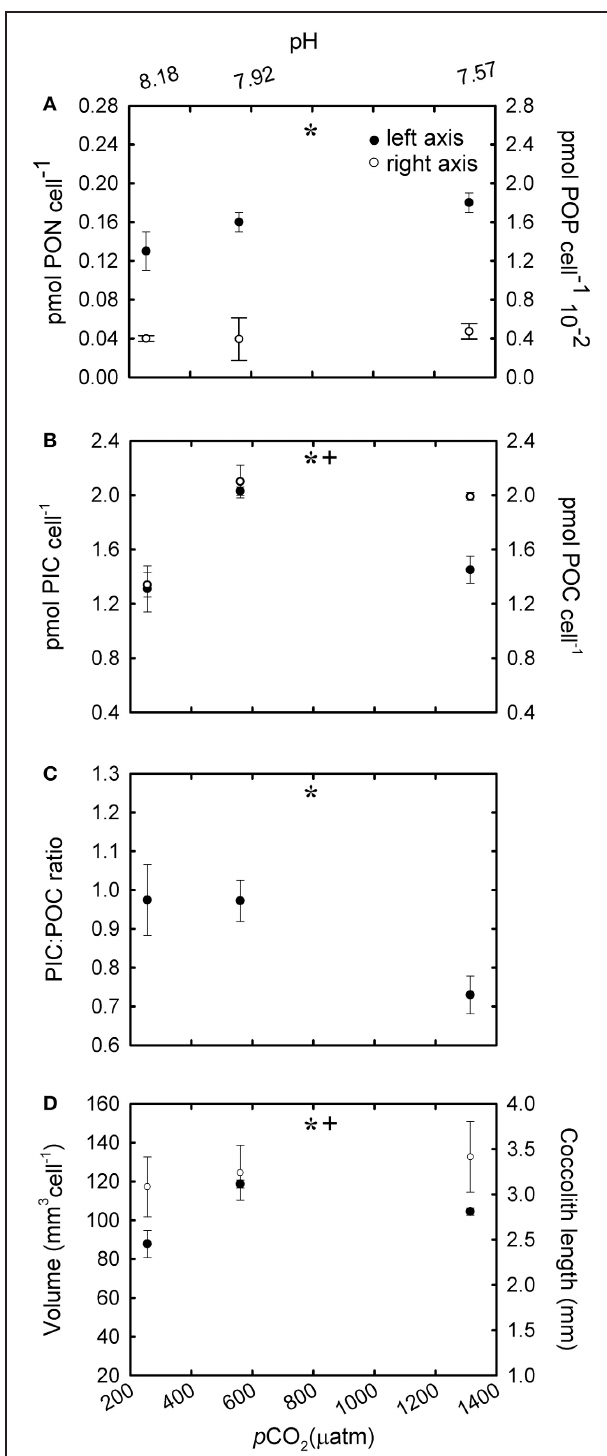
FIGURE 6 | The response of Emiliania huxleyi NZEH to different CO 2 scenarios under phosphate limited conditions. (A) Cellular PON quota, cellular POP quota; (B) Cellular PIC quota, cellular POC quota; (C) PIC:POC; (D) Coccosphere volume ( µ m 3 ) and coccolith length ( µ m). ( ∗ and + ) significant differences ( p < 0 . 05) between CO 2 levels within nutrient treatments from One-Way ANOVA analysis: left ( ∗ ) and right( + )